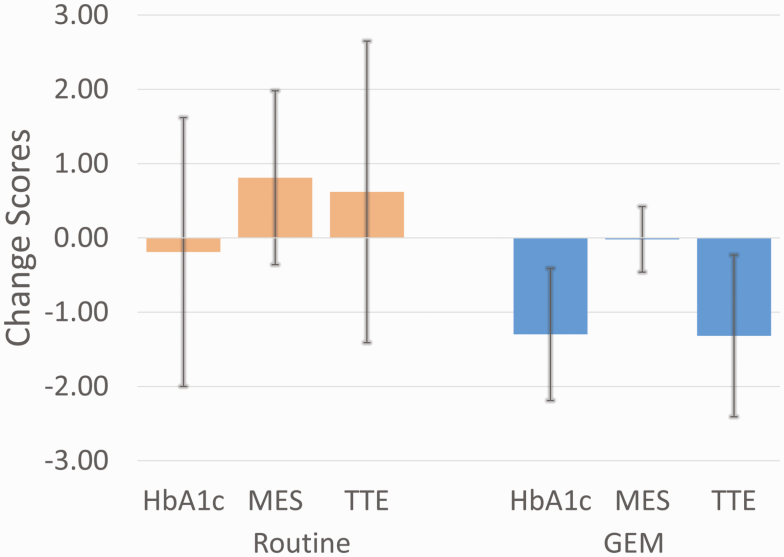
Means and SDs for glycated hemoglobin (HbA1c), medication effect score (MES), and total treatment effect (TTE) pre to post change scores.